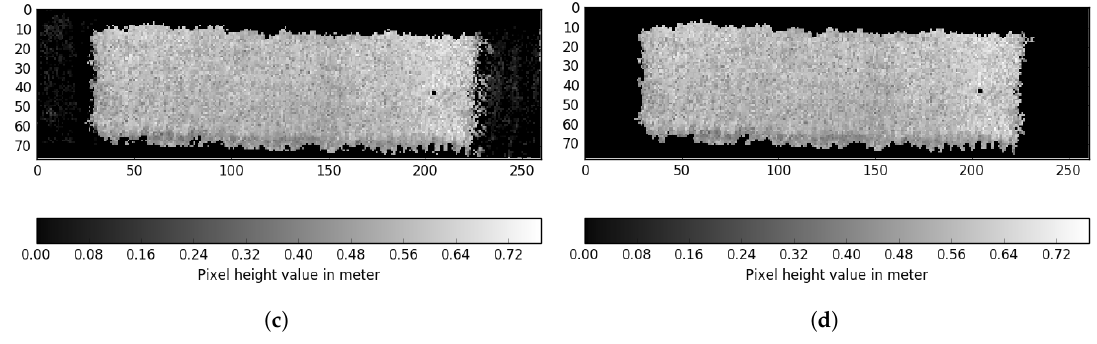
Figure 6. Voxel grid crop parcel processing. ( a ) initial pixel grid after conversion from voxel grid; ( b ) pixel interpolation for the detected surface area; ( c ) ground-level removal from pixels; ( d ) crop parcel height estimation using region